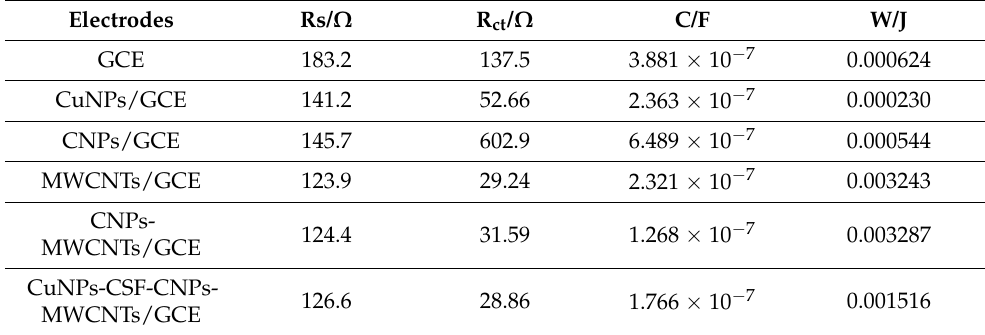
Table 1. The values of EIS equivalent circuit elements for each